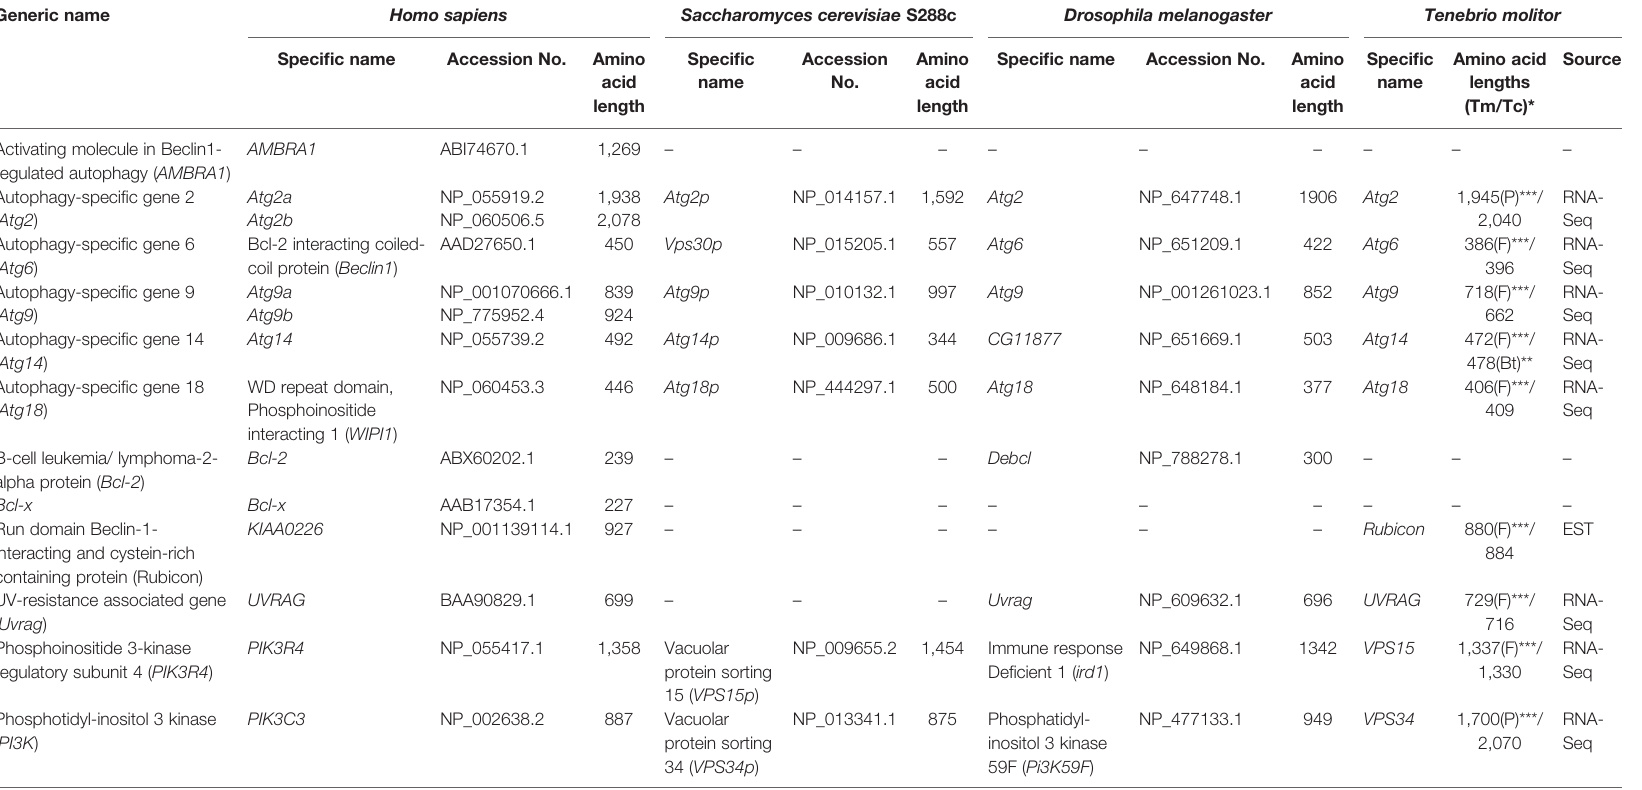
TABLE 3 | Autophagy-related genes involved in vesicle nucleation in T. molitor